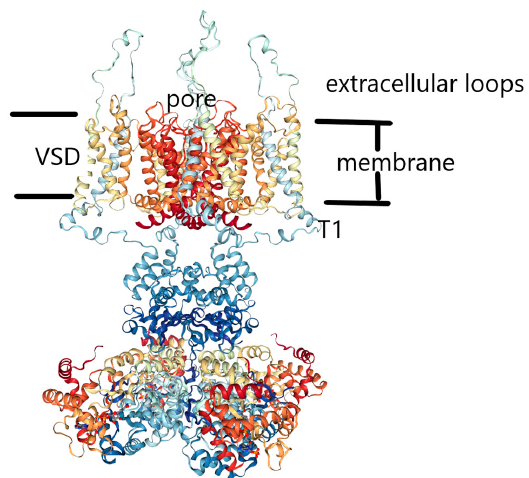
Figure 1. (reproduced from protein data base, pdb code 3Lut [19]: The membrane is indicated by the two boundaries, with the extracellular one above. The extracellular loops connect TM (transmembrane) segments; the voltage sensing domains (VSD, there are four, the one on the left labeled) each have four helical segments, and the pore has eight such segments, two from each VSD. The T1 moiety below the intracellular membrane boundary is part of the postulated proton pathway; it is known experimentally to affect gating [23]. The pore section is in the